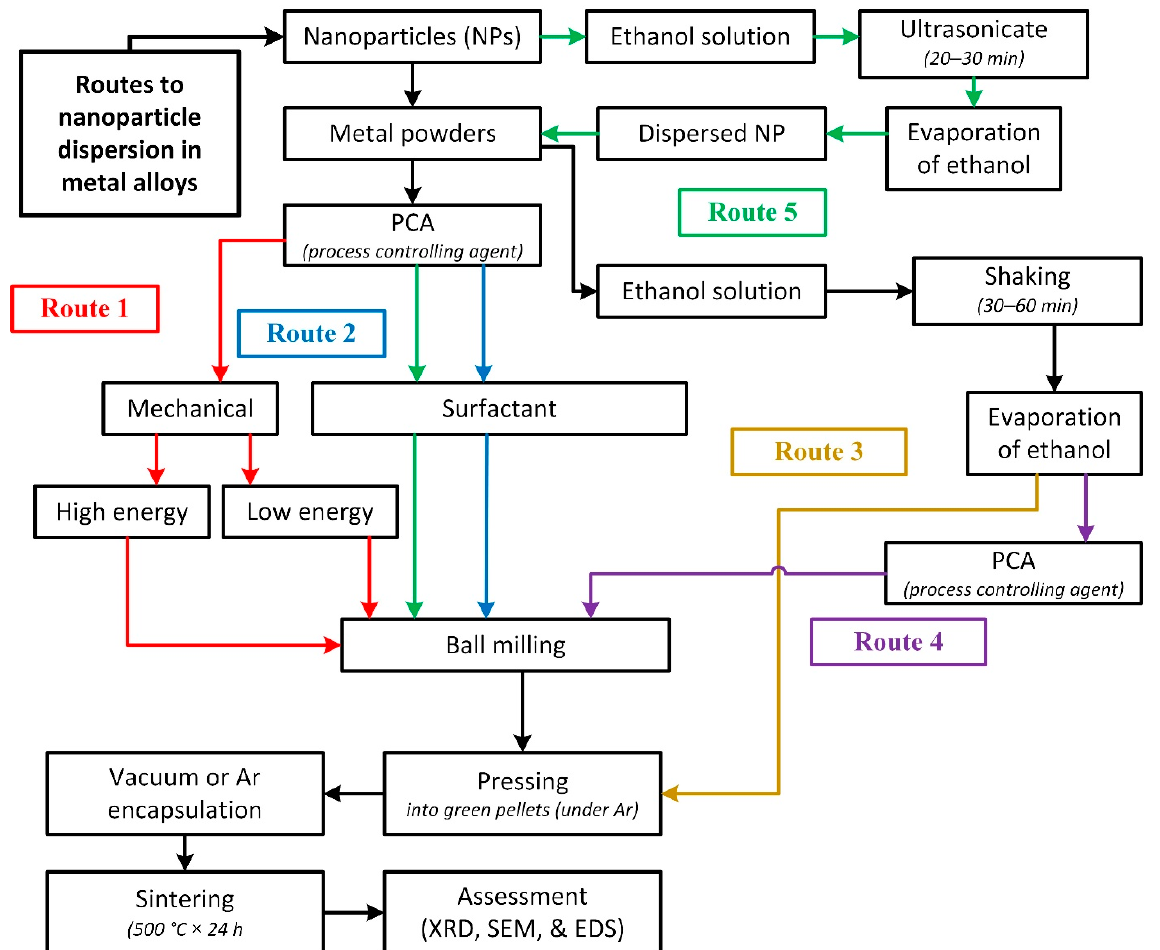
Figure 3. Flowchart diagram for different routes with the mechanochemical powder processing. XRD: X-ray Diffraction. EDS: energy-dispersive X-ray spectroscopy.